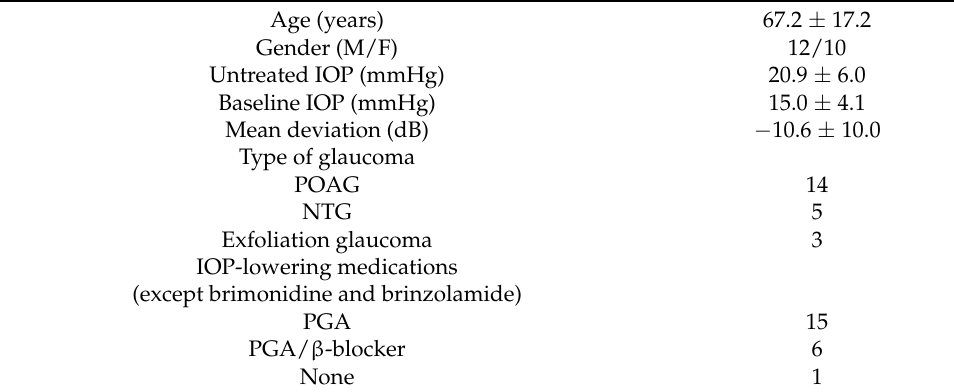
Table 1. Baseline patient